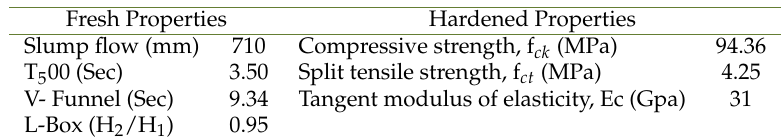
Table 3. Fresh and Hardened Properties of HSSCC